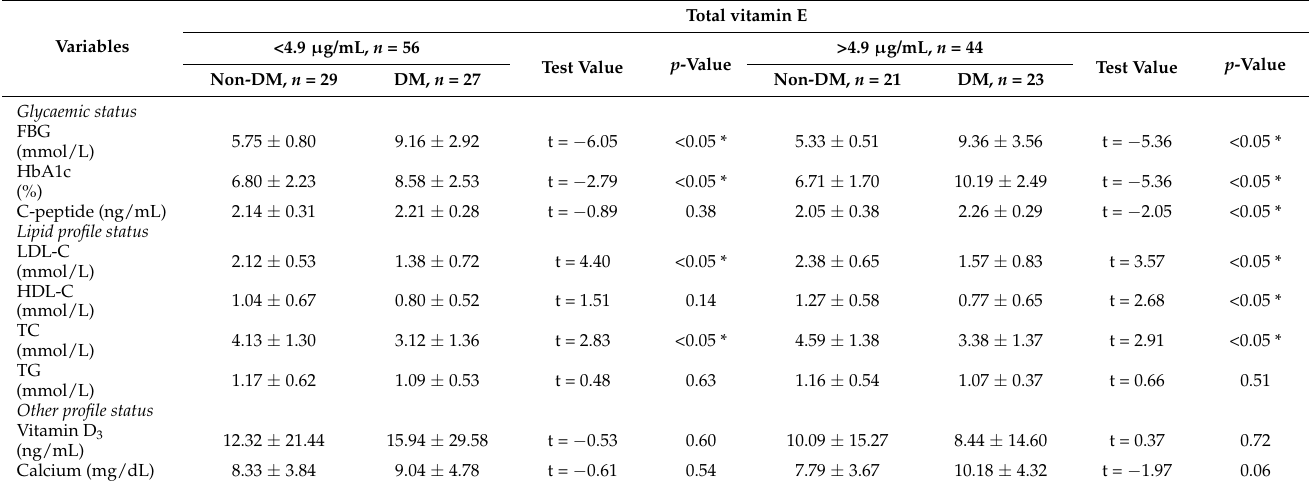
Table 8. The relationship of plasma total vitamin E with biochemical parameters in groups using the cut-off baseline adopted from plasma total vitamin E in both